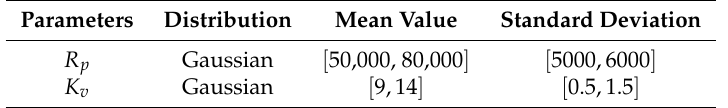
Table 2. Imprecise uncertainties in model parameters represented as parametric